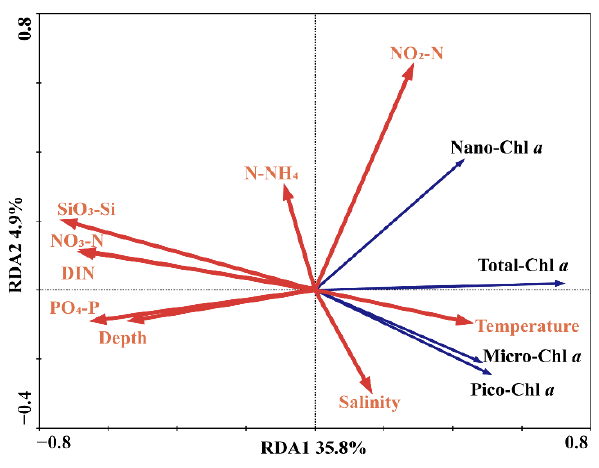
Figure 7. Redundancy analysis (RDA) plot for the relationship between size-fractionated Chl a groups and environmental variables in NESCS. The blue vectors correspond to size-fractionated Chl a . The red vectors show the direction and strength of the environmental variables relative to the overall distribution. The concentrations of size-fractionated Chl a were log-transformed prior to analysis. Table 3. Pearson’s rank correlation coefficients between environmental factors and concentrations of size-fractionated Chl a . The concentrations of size-fractionated Chl a were log transformed prior to analysis. * p < 0.05 (2-tailed); ** p < 0.01 (2-tailed).